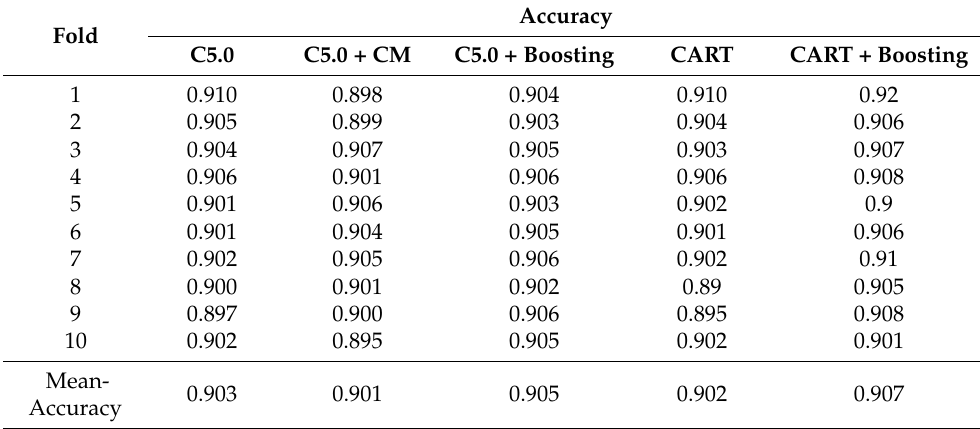
Table 13. Accuracy of 10-fold